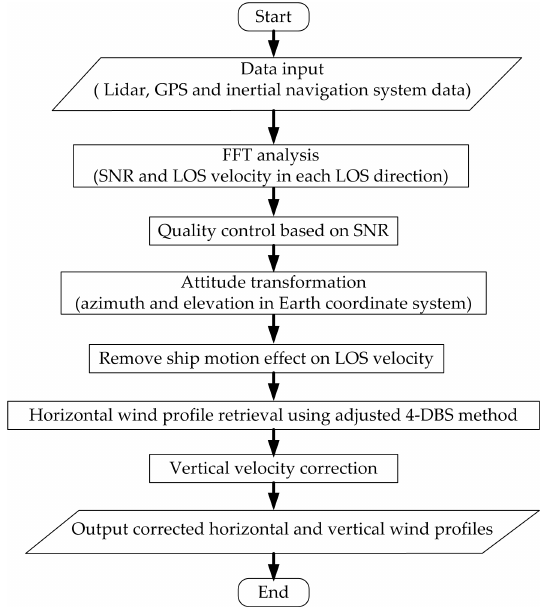
Figure 4. Flow chart of ship motion correction algorithm based on CDL.